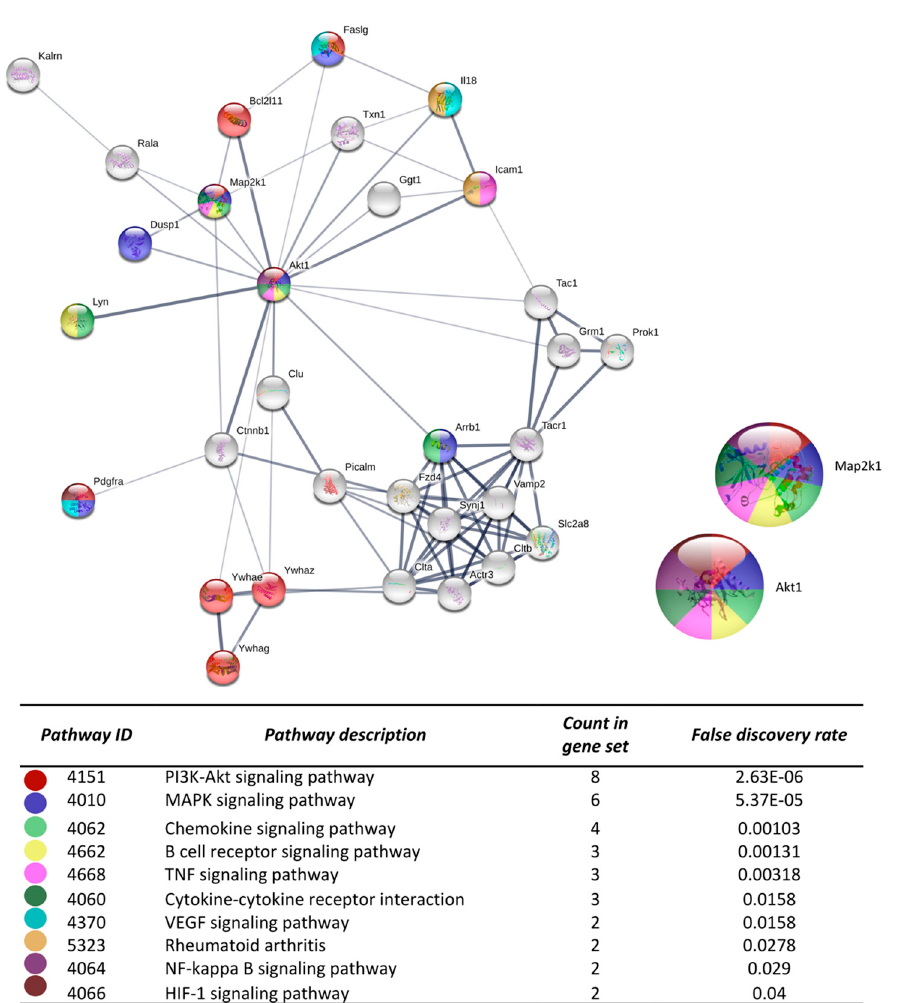
Figure 4. The protein-protein interaction network construction of the cluster number two obtained with the differentially expressed genes. The lists of the differentially expressed genes (Z-score ≥ 1.5 SD) were analyzed on the STRING and Cytoscape platforms. The primary clusters of sub-networks were obtained using the Molecular Complex Detection (MCODE) complement (cutoff = 0.2). Line thickness indicates the strength of data support; colored nodes indicate query proteins and first shell of interactors; white nodes indicate the second shell of interactors.